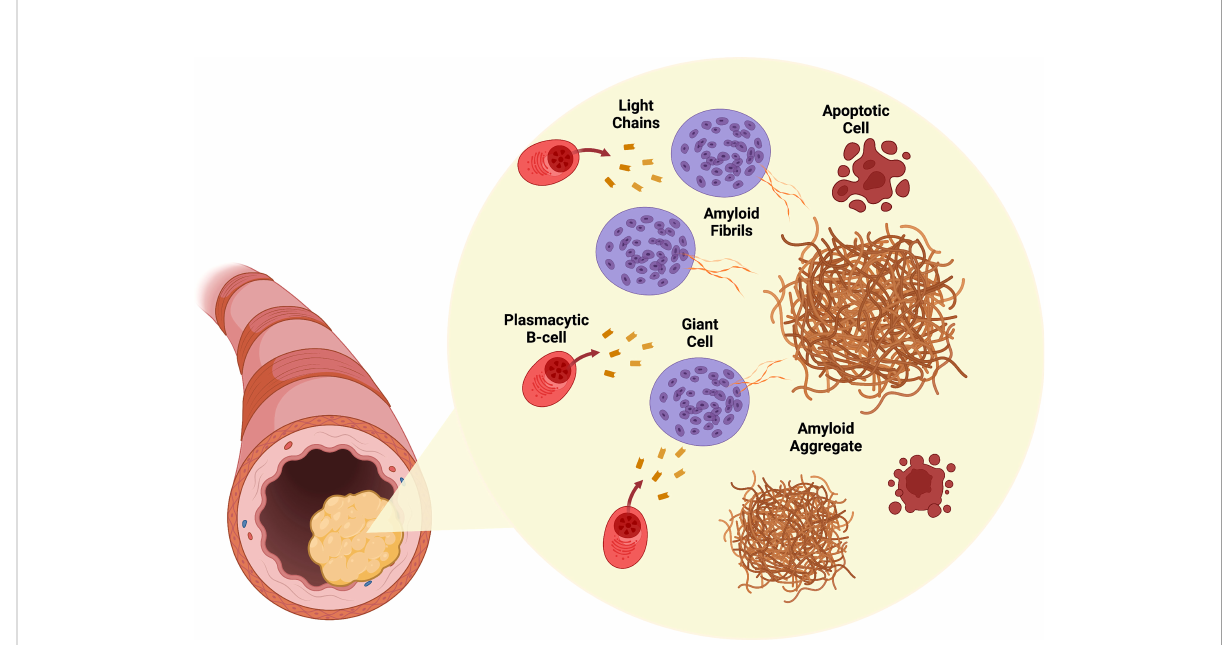
FIGURE 1 Pathogenesis of AL L amyloidosis. In fi ltrating plasmacytic B-cells locally produce amyloidogenic light chains. Surrounding giant cells process these light chains into amyloid fi brils. Accumulation of amyloid fi brils in the involved organ (larynx shown) results in tumor growth. Cytotoxic amyloid fi brils are toxic to plasmacytic B-cells. Created with